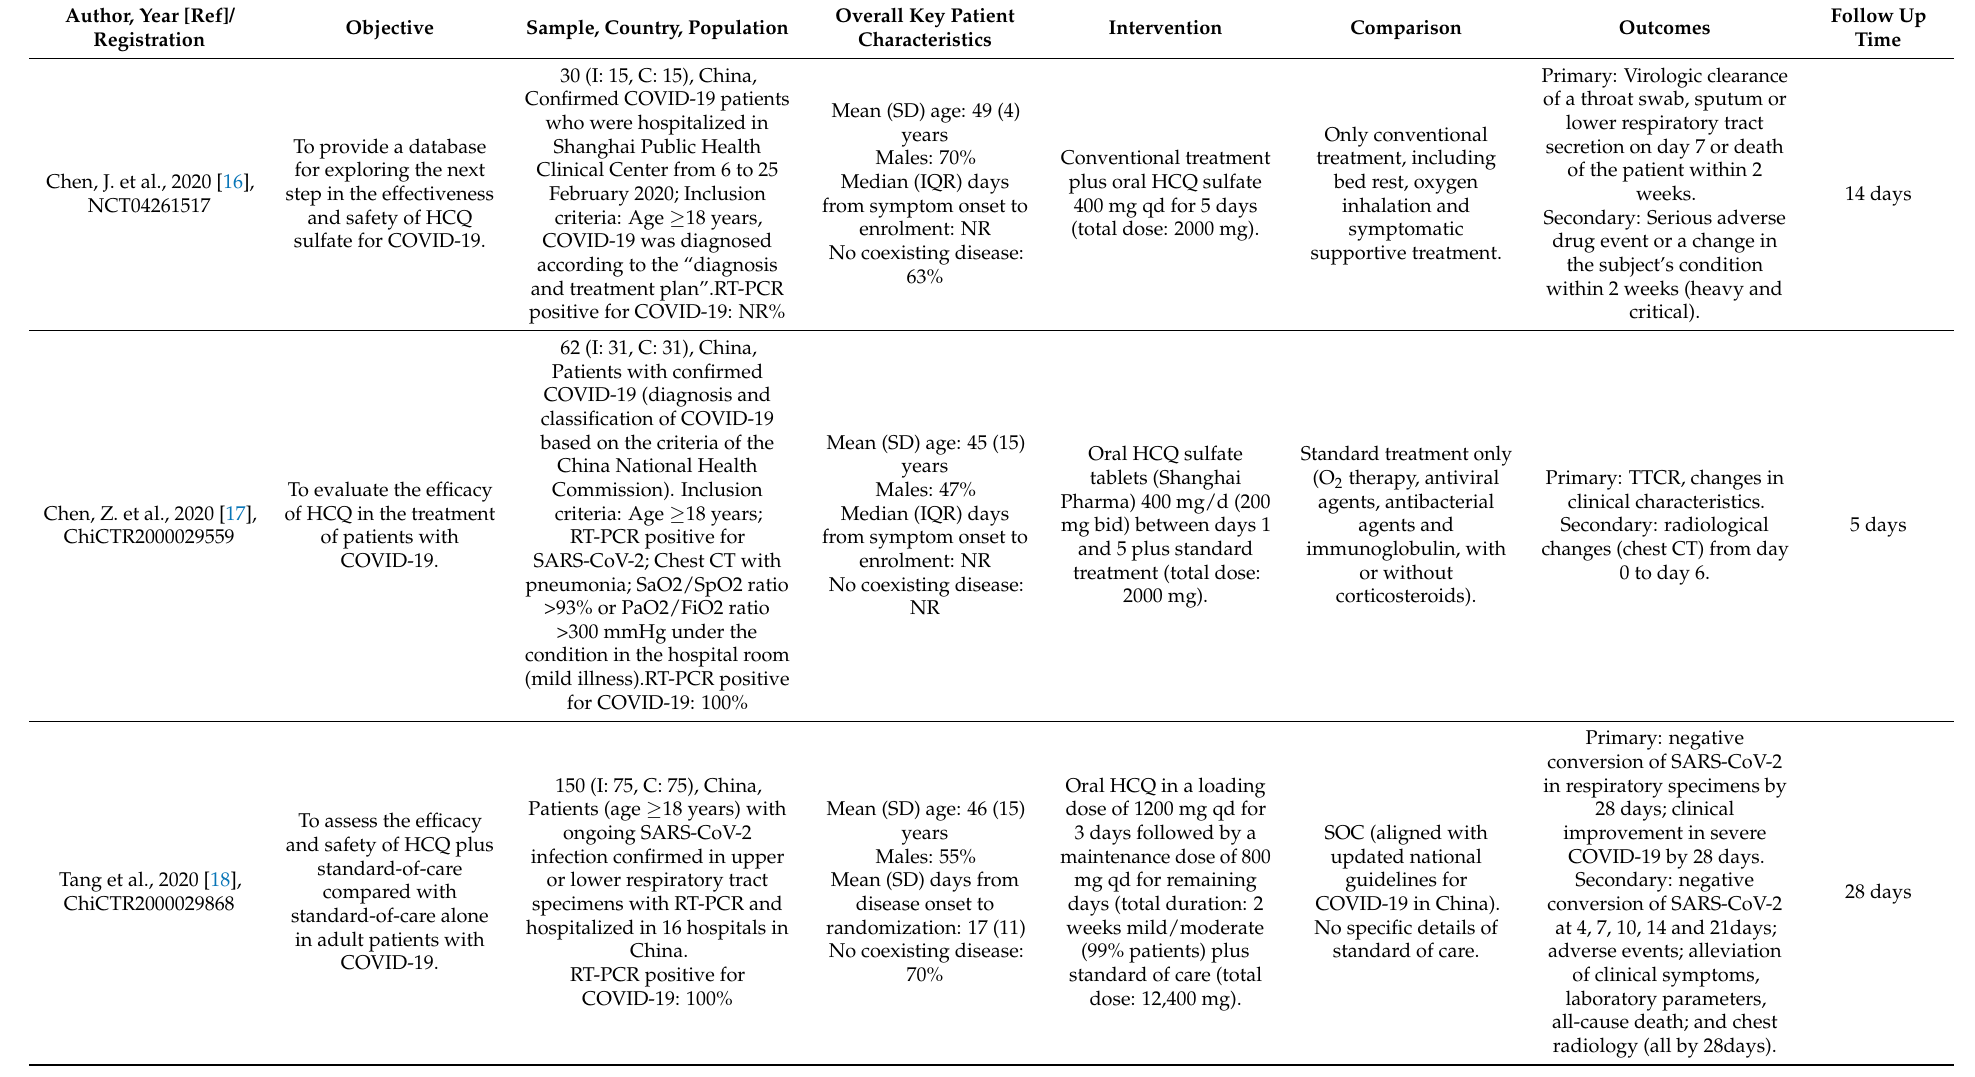
Table 1. Baseline characteristics of included randomized controlled